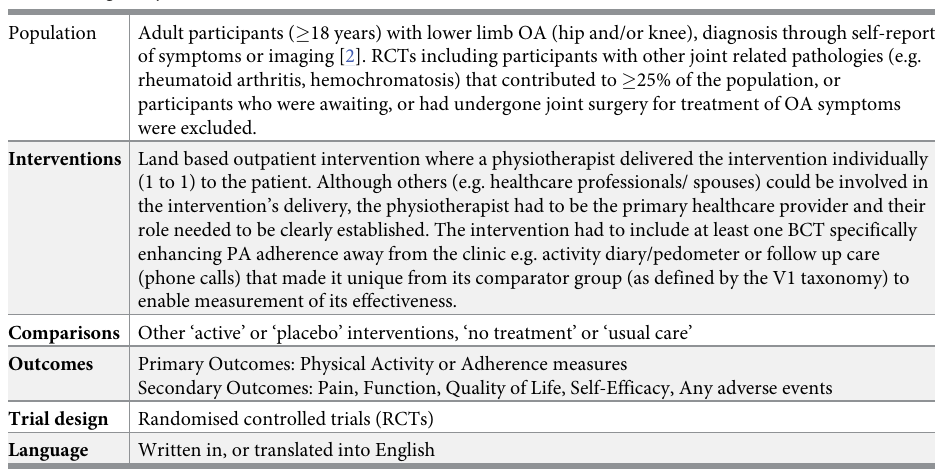
Table 1. Eligibility